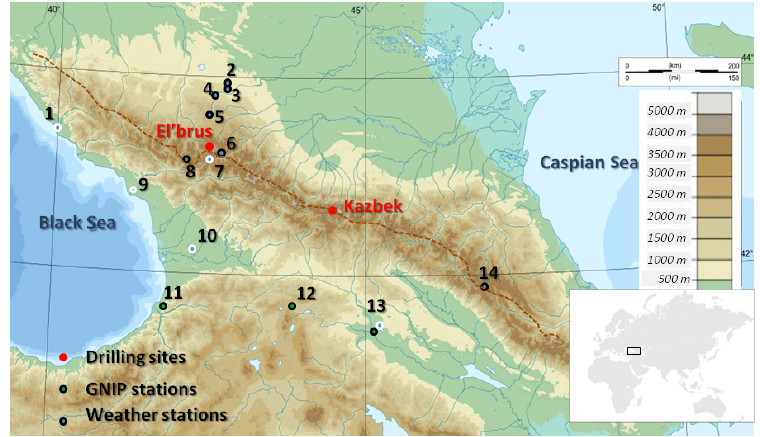
Figure 1. Map showing the region around El’brus (black rectangle in the world map in the lower right corner), with shading indicating elevation (ma.s.l.). Drilling sites are indicated as red filled circles, GNIP stations as green filled circles, and meteorological stations as blue dots. Stations situated to the south of the main Caucasus Ridge according to the precipitation cycle pattern are shown using a blue dot surrounded by a white circle and the stations situated to the north are displayed surrounded by a black circle (see text for details). The brown dotted line shows the border between two types of precipitation seasonal cycles. The numbers of the various stations refer to Table 1, where detailed descriptions are